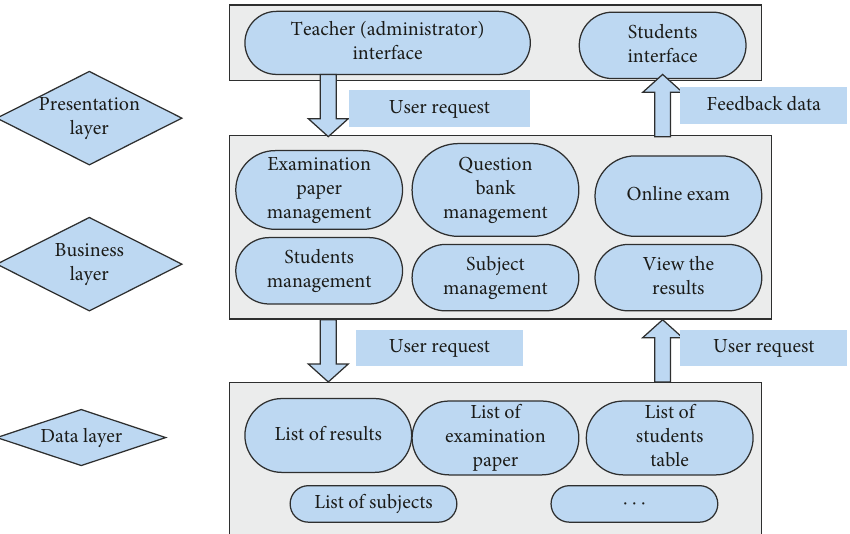
Figure 8: Overall architecture of the